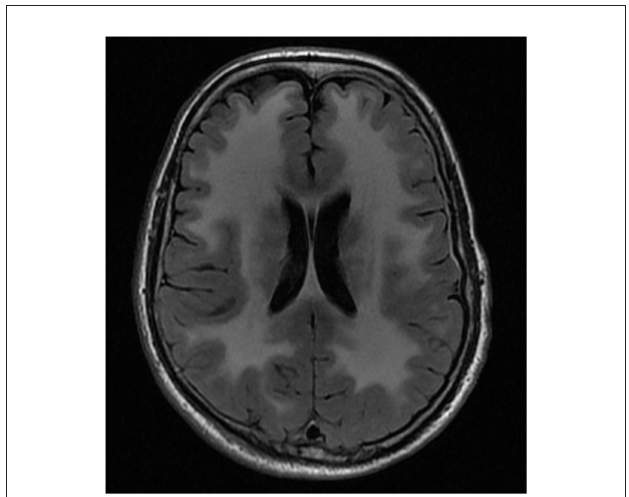
FIGURE2 MRI brain of proband. Axial FLAIR * image from MRI brain of proband at 64 years of age showing confluent, bilateral white matter T2# hyper intensity with involvement of the corpus callosum * FLAIR, Fluid-attenuated inversion recovery; #T2, transverse relaxation